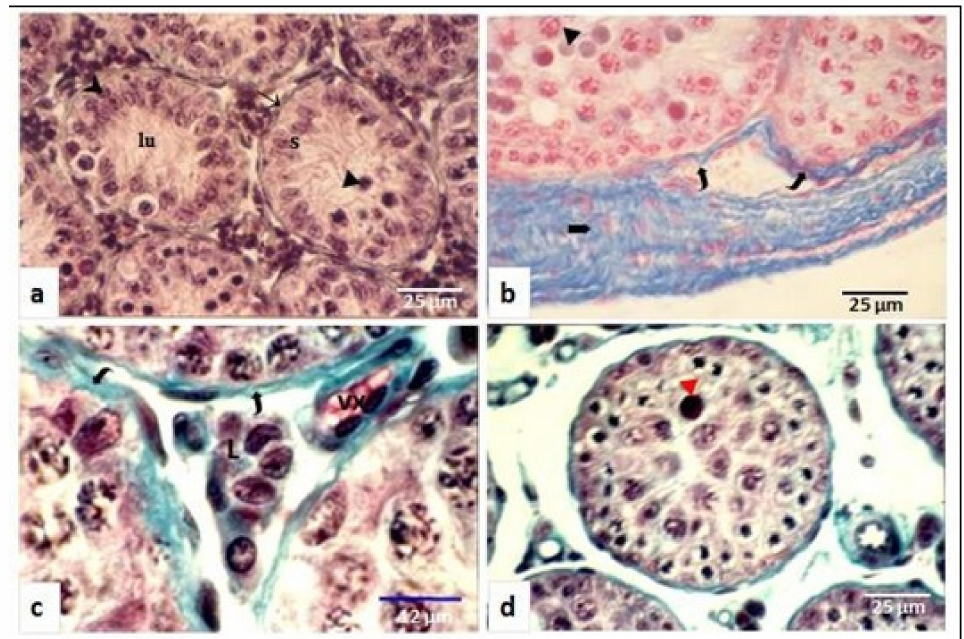
Figure 1. Testicular structure of Meriones libycus in the breeding period (spring and early summer). ( a ) Seminiferous tubules diameter ( ) is high (700 μ m ± 806 μ m) with regular outline Leyding cells ( ) are observed in the inter-tubular space. ( b ) The spermatogenesis is very active and numerous spermatozoa (SPZ) are accumulated in the lumen of the seminiferous tubule. ( c ) Leydig cells (L) are large and arranged around blood vessels (Vx), and the basement membrane ( ⊇ ) is regular, intact, and thin. ( d ) Leydig cells (L) are located in the vicinity of the seminiferous tubules ( ). a: ×100; b: ×400; c, d: ×1250. During the nonbreeding period (autumn), the diameter of seminiferous tubules de- creased (300 μ m ± 6.4 μ m) significantly, ( p < 0.001), and the lumen was reduced or some- times absent (Figure 2a,c). Sperm was absent and spermatogenesis was stopped at the spermatogonia stage in most observed tubules, with spermatogonia located near the basement membrane that became thick and pleated (Figure 2a–c). Sertoli cells were nu- merous, and their nuclei with an oval or round shape were far from the basal lamina (Figure 2a). In the inter-tubular space, very small-sized Leydig cells were grouped (Fig- ure 2b).